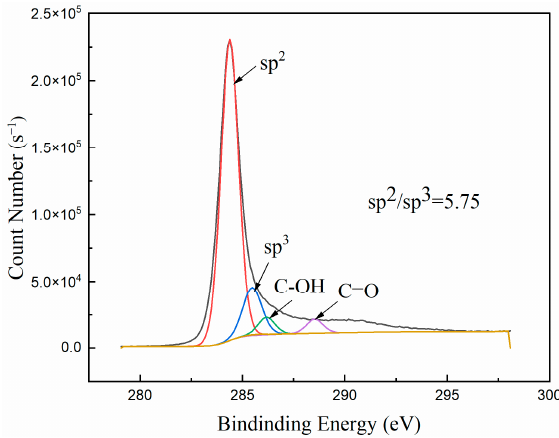
Figure 9. C1s peak for the GDI soot with curve fi tt ing for component resolution.